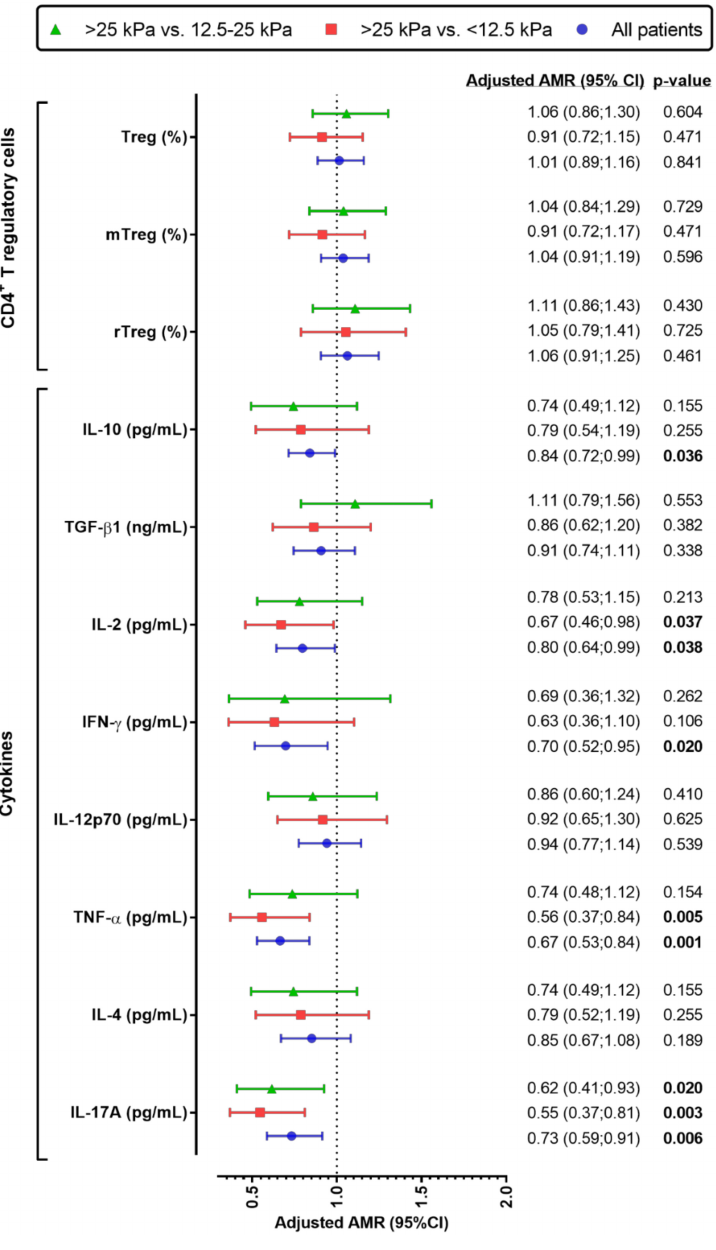
Figure 2. Values of the relationship between liver stiffness measure (continuous and categorical) and peripheral blood biomarkers (CD4 + Treg cells and plasma cytokines), adjusted by the main clinical and epidemiological covariables, in HIV/HCV-coinfected patients. Blue ( ): Values of adjusted arithmetic mean ratio (aAMR) in HIV/HCV-coinfected patients. Red ( ): Values of aAMR for patients with >25 kPa versus patients with <12.5 kPa (reference). Green ( ): Values of aAMR for patients with >25 kPa versus patients with 12.5–25 kPa (reference). Statistics. p -values were calculated by the Generalized Linear Models test with a gamma distribution (log-link). Each regression test was adjusted by age, gender, baseline CD4 + T cells, HIV viral load ( ≥ 50 cp/mL), high alcohol intake, diabetes, log 10 HCV RNA, HCV-GT1, previous IFN α HCV therapy, and prior AIDS diagnosis. Abbreviations: HCV, hepatitis C virus; HIV, human immunodeficiency virus; LSM, liver stiffness measure; aAMR, adjusted arithmetic mean ratio; CI, confidence interval; CDXX, cluster of differentiation; TGF- β 1, transforming growth factor beta 1; IFN- γ , Interferon gamma; IL-XX, interleukin; Treg cells, regulatory CD4 + T cells; TNF- α , tumor necrosis factor